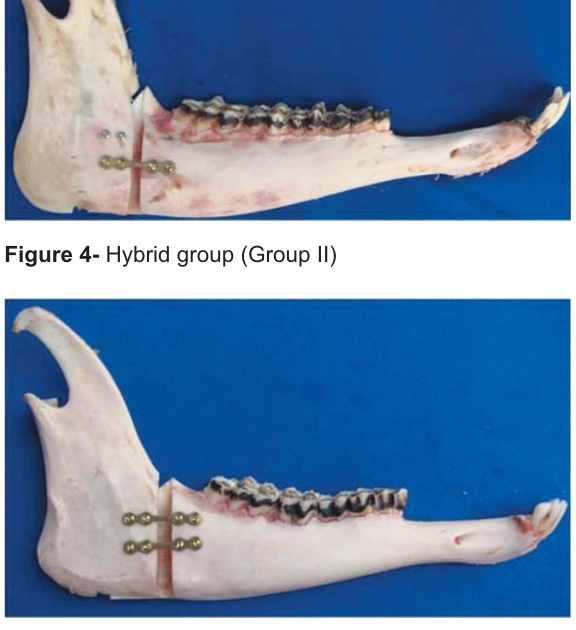
Figure 5- Plates group (Group III)